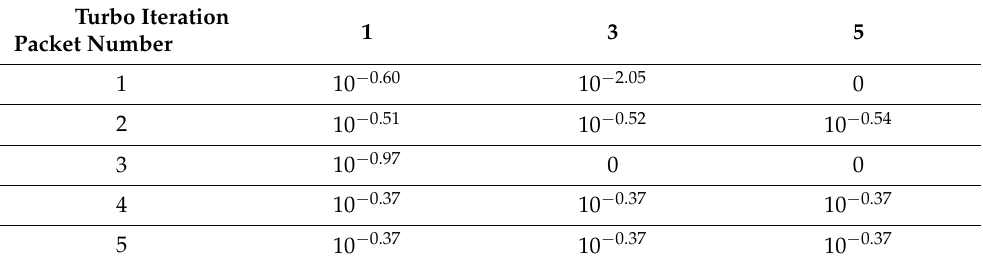
Table 3. Performance analysis according to the number of Turbo iterations. ( N c = 8, N b = 4). Turbo Iteration